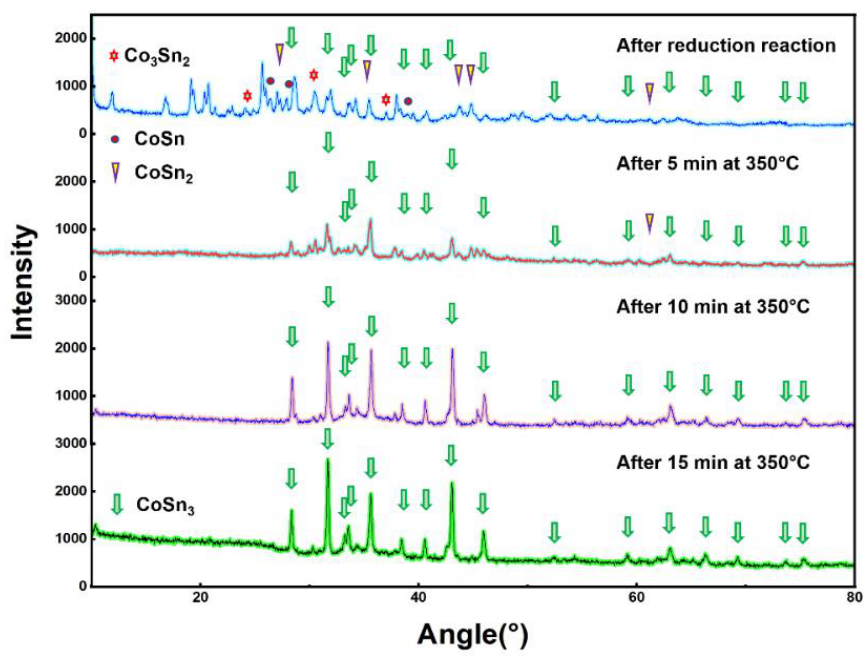
Figure 6. XRD scanning pattern after heating in a tube furnace for 0 min, 5 min, 10 min, and 15 min